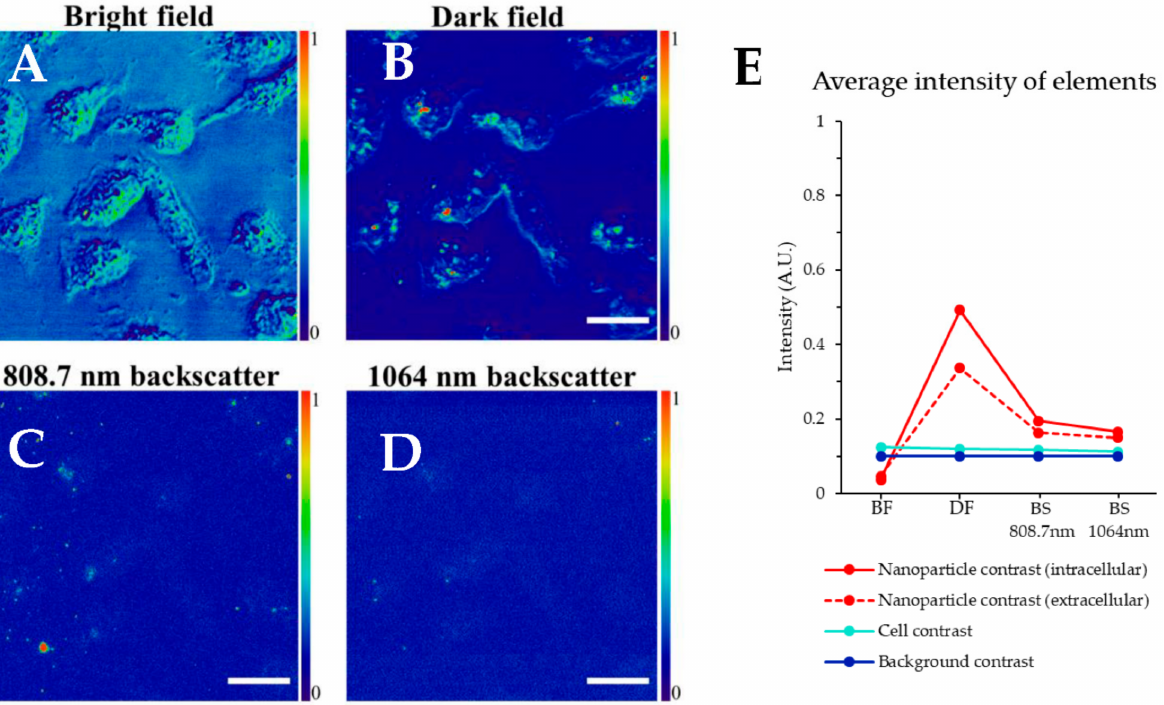
Figure 2. Single beam laser microscopy images of magnetic nanoparticles uptaken in GR-KLM-1 cells, ( A ) transmission bright field (BF) with 808.7 nm illumination, ( B ) transmission dark field (DF) with 808.7 nm illumination and ( C ) epi-detected backscatter (BS) with 808.7 nm, and 1064 nm illumination ( D ). All scale bars are 20 µ m. ( E ) shows the average intensity of the various image elements, see legend, data is offset by and scaled to the background intensity to aid comparison, with error bars indicating one standard deviation for 10 measurements. Solid and dotted trendlines have been added to aid